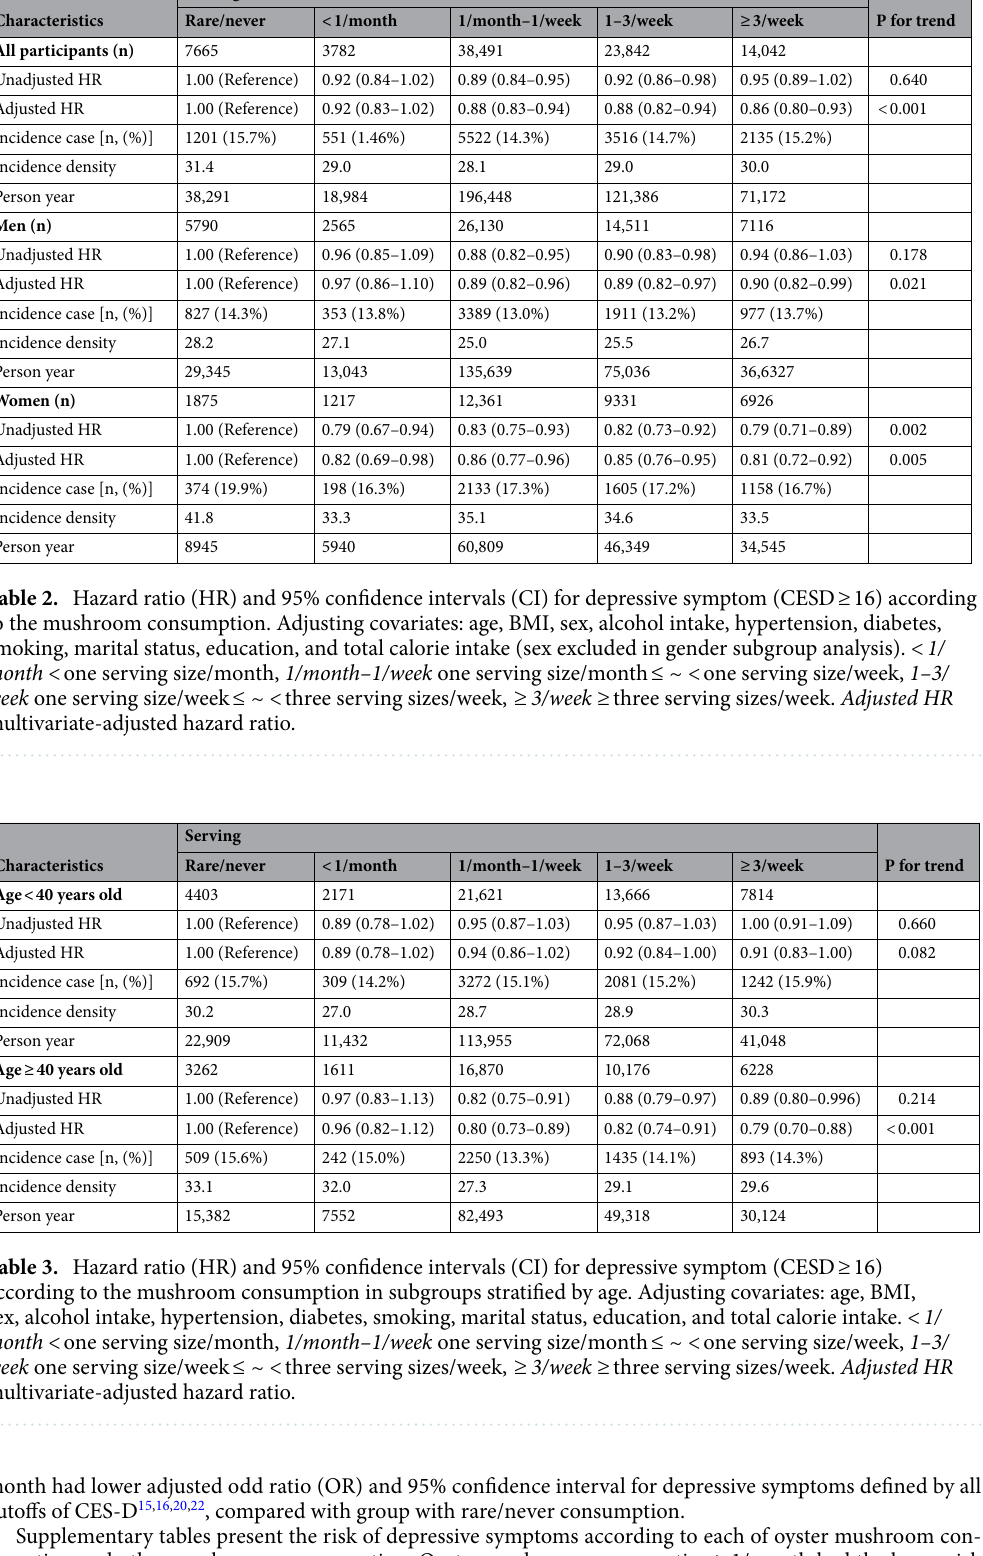
month had lower adjusted odd ratio (OR) and 95% confidence interval for depressive symptoms defined by all cutoffs of CES-D 15,16,20,22 , compared with group with rare/never consumption. Supplementary tables present the risk of depressive symptoms according to each of oyster mushroom con- sumption and other mushrooms consumption. Oyster mushroom consumption ≥ 1/month had the lower risk for depressive symptoms than rare/never consumption in both men and women (Supplementary Table 1). This association was observed only in age subgroup with age ≥ 40 years (Supplementary Table 2). Analysis for other mushrooms also showed the similar patterns of relationship with those in analysis for oyster mushroom, despite statistical insignificance in some cases (Supplementary Tables 3 and 4).